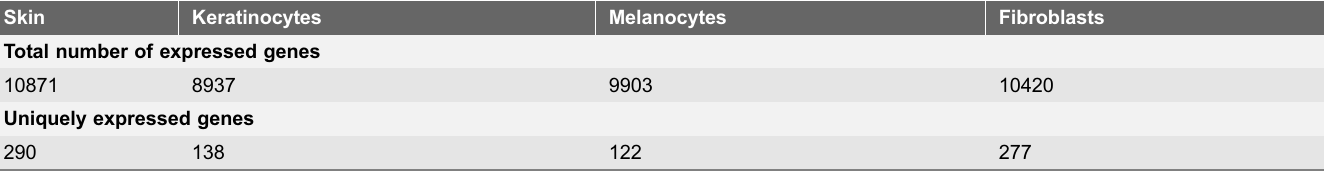
Table 1. The number of detected and uniquely expressed